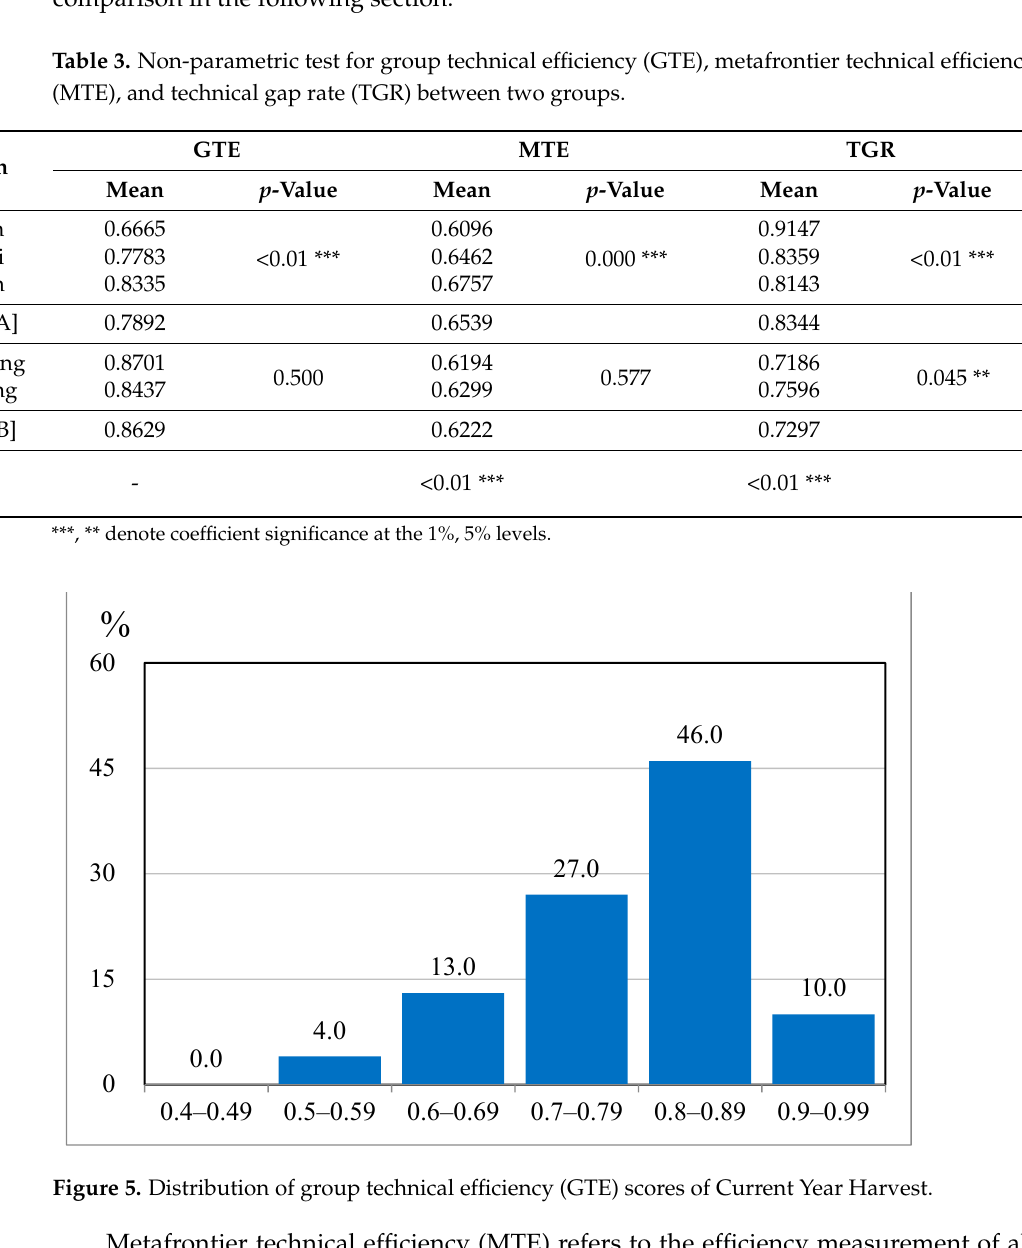
Figure 6. Distribution of group technical efficiency (GTE) scores of Overwinter Harvest. Metafrontier technical efficiency (MTE) refers to the efficiency measurement of all farmers in both culturing models while considering the impact of environmental differences. It also refers to the ratio of the actual production level of different farmers to the production level on the metafrontier. The numerical calculation results of the metafrontier coefficient in Table 3 shows that the overall average MTE is 0.6408 (Figure 7). This implies that only 64.08% of the potential technical efficiency is achieved based on the current input-output combination and accounting for the differences in environmental factors, which leaves 35.92% improvement potential. Thus, work must be done to reduce input costs and increase output to improve overall technical efficiency. According to the verification results (Table 3), the MTE value of the current year harvest model is 0.6539, which is significantly higher than the 0.6222 value of the overwintering harvest model. Consistent with the GTE results, the Tainan area is still the highest (0.6757) of the three areas under the current year harvest model, followed by Jiayi and Yunlin. Thus, it indicates that Yunlin has the greatest room for efficiency improvement. There are significant differences in the MTE values between the three areas.